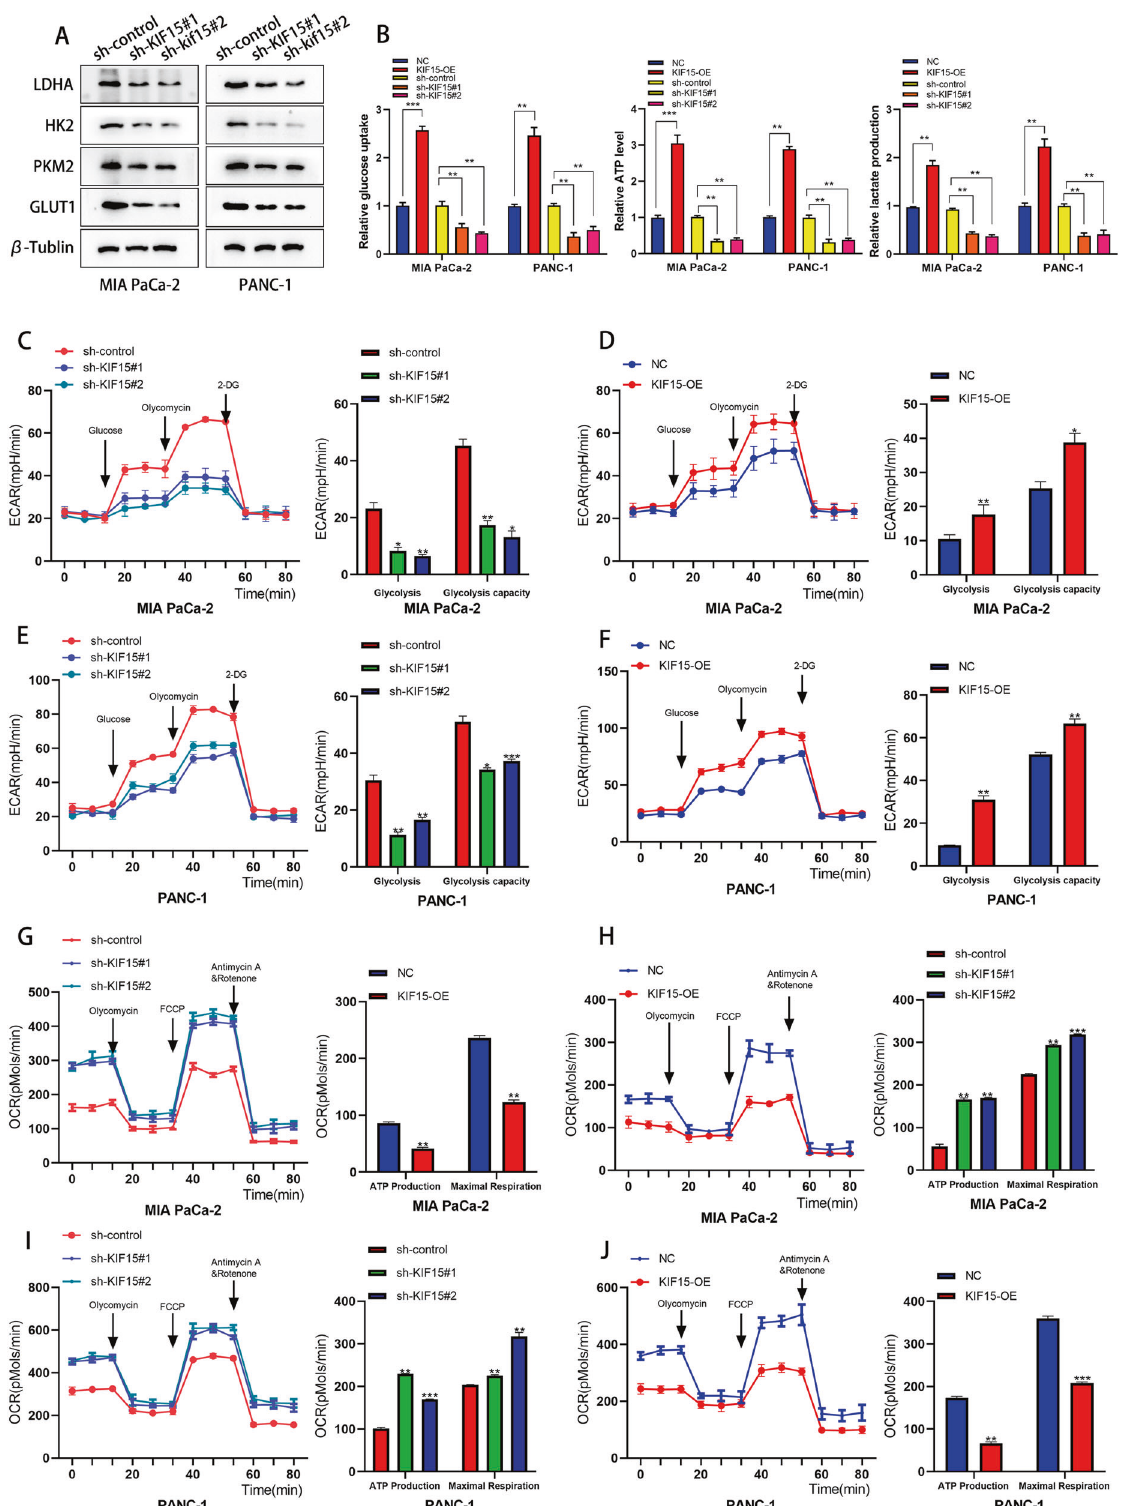
Fig. 3 KIF15 promoted the glycolysis of PC cells. A The Western blot assay of glycolysis markers in PC cells. B The glucose uptake, ATP and lactate production assay of PC cells. C The ECAR assay and quanti fi cation of Mia PaCa-2 cells transfected with KIF15 shRNA. D The ECAR assay and quanti fi cation of Mia PaCa-2 cells transfected with KIF15 overexpression plasmids. E The ECAR assay and quanti fi cation of PANC-1 cells transfected with KIF15 shRNA. F The ECAR assay and quanti fi cation of PANC-1 cells transfected with overexpression plasmids. G The OCR assay and quanti fi cation of Mia PaCa-2 cells transfected with KIF15 shRNA. H The OCR assay and quanti fi cation of Mia PaCa-2 cells transfected with KIF15 overexpression plasmids. I The OCR assay and quanti fi cation of PANC-1 cells transfected with KIF15 shRNA. J The OCR assay and quanti fi cation of PANC-1 cells transfected with KIF15 overexpression plasmids. Cell Death and Disease (2023)